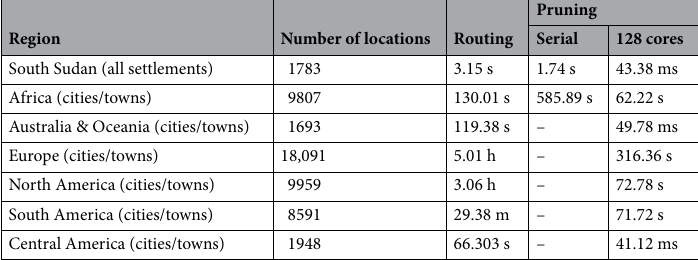
Table 5. Performance of the triangular pruning for the undirected routing